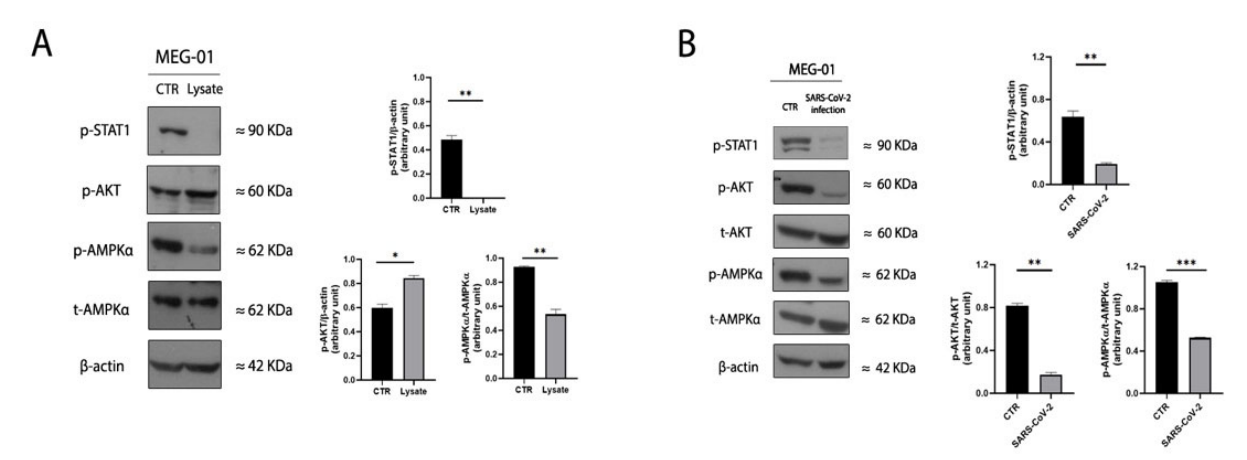
Figure 3. SARS ‐ CoV ‐ 2 stimulation alters the megakaryopoiesis pathway and AMPK activity in undifferentiated MEG ‐ 01. ( A ) Panel shows immunoblot bands and relative quantification of control and inactivated SARS ‐ CoV ‐ 2 ‐ exposed whole ‐ cell lysates of undifferentiated MEG ‐ 01 cells immunoblotted for p ‐ STAT1, p ‐ AKT, p ‐ AMPK α , total AMPK α , and β‐ actin. On the right side, bar graphs represent the expression levels of p ‐ STAT1, p ‐ AKT, and p ‐ AMPK α quantified by densitometry and normalized to the respective loading control β‐ actin. Pairwise comparisons are reported (ordinary one ‐ way ANOVA; * p < 0.05, ** p < 0.01 , *** p < 0.001). The results are representative of three independent experiments expressed as mean ± SD. ( B ) Panel shows control and SARS ‐ CoV ‐ 2 ‐ infected whole ‐ cell lysates of undifferentiated MEG ‐ 01 cells immunoblotted for p ‐ STAT1, p ‐ AKT, total AKT, p ‐ AMPK α , total AMPK α , and β‐ actin. On the right side, bar graphs represent the expression levels of p ‐ STAT1, p ‐ AKT, and p ‐ AMPK α , quantified by densitometry. The band densities of the proteins were normalized to the respective loading control β‐ actin or to the respective total protein. Pairwise comparisons are reported (ordinary one ‐ way ANOVA; ** p < 0.01, *** p < 0.001, no significant p ‐ values are not shown). The results are representative of three independent experiments expressed as mean ± SD.